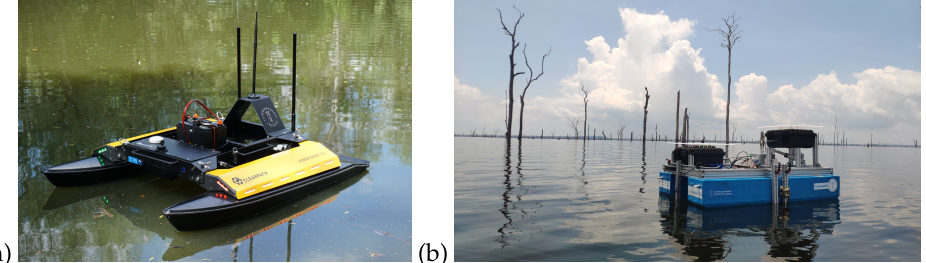
Figure 3. The used ASV’s ( a ) “Elisabeth” Clearpath Kingfisher and ( b ) “Ferdinand” with the operating system and the